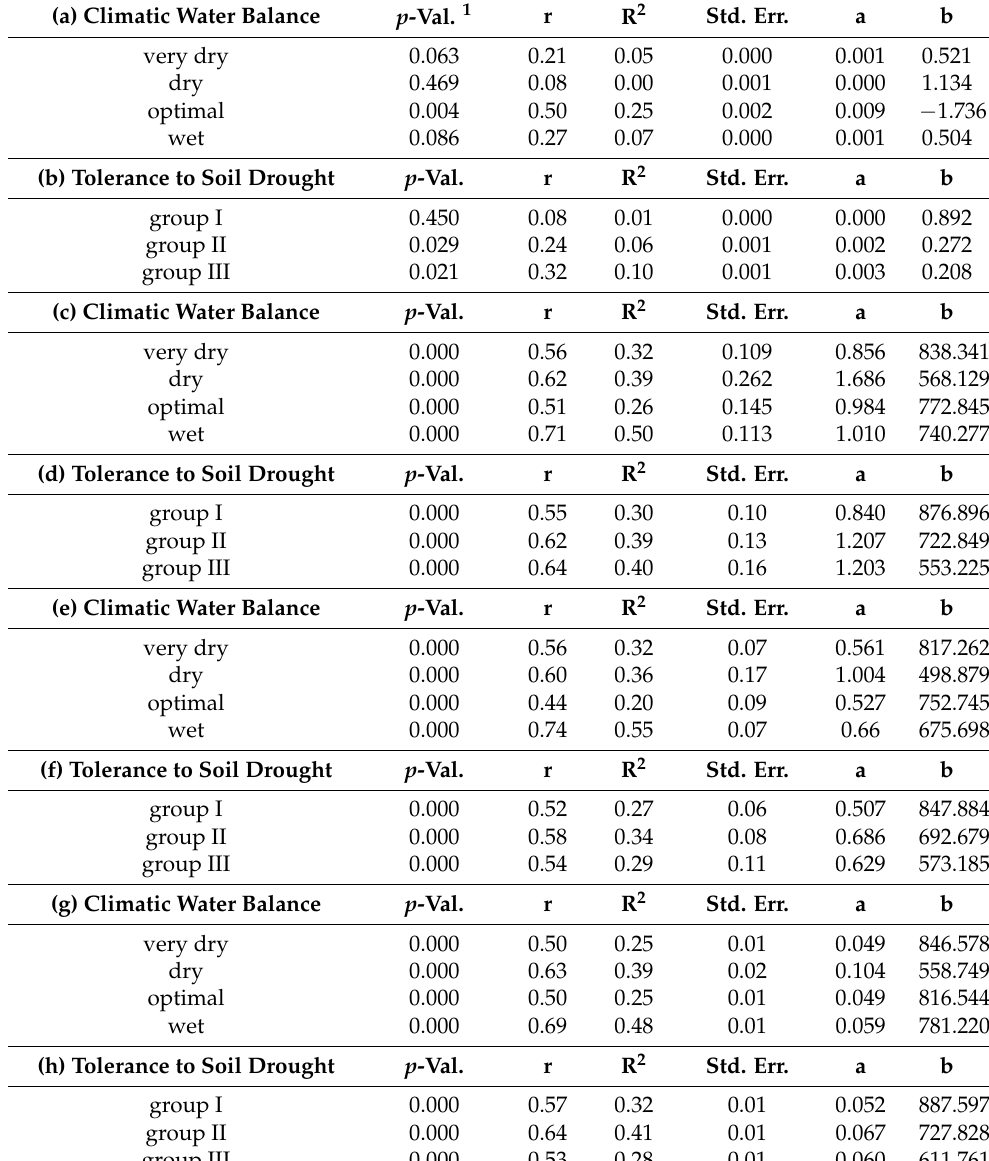
Table 4. Linear modeling results for relation between agronomic parameters against categories: climatic water balance or against tolerance to soil drought group, presented for parameters sets: (a) & (b) leaves mass and MSTI, (c) & (d) leaves mass and yield per plant, (e) & (f) stem and leaves mass and yield per plant, (g) & (h) assimilation area and yield per